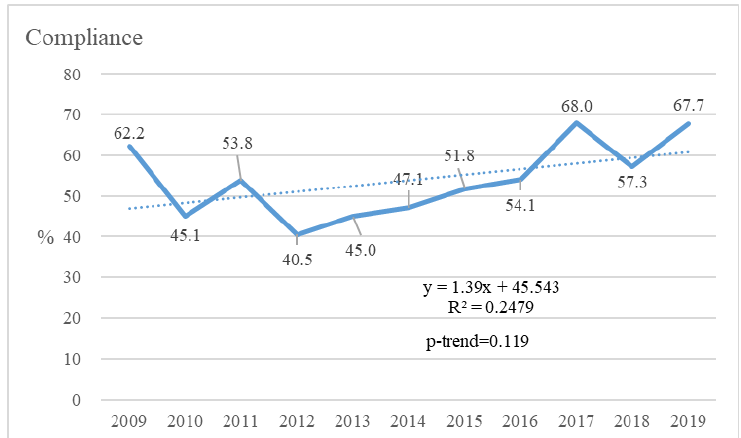
Figure 1. The trend of compliance rate from 2009 to 2019. Since juvenile offender rate had no difference with the test result, the remaining var- iables were further analyzed in the logistic regression model. Among the independent variables, higher exposure rate to secondhand smoke at home (Adjusted odds ratio = 0.977, 95%CI = 0.963 – 0.991), higher smoking rate among senior and vocational high school students (AOR = 0.964, 95%CI = 0.945 – 0.984), and male adolescent rate (AOR = 0.887, 95%CI = 0.818 – 0.962) were associated with lower compliance. Among the test variables, the years of survey (AOR = 1.085, 95%CI = 1.051 – 1.120), inspection during summer vacation (AOR = 1.324, 95%CI = 1.163 – 1.507), chain conven- ience stores (AOR = 3.651, 95%CI = 3.099 – 4.301), supermarkets or hypermarkets (AOR = 1.973, 95%CI = 1.625 – 2.396), and sellers verified with age (AOR = 15.345, 95%CI = 13.159 – 17.893) were associated with better compliance; however, the county/city with the average highest disposable income (AOR = 0.572, 95%CI = 0.468 – 0.698) and second highest dispos- able income (AOR = 0.818, 95%CI = 0.673 – 0.993), and tests on weekends (AOR = 0.784, 95%CI = 0.688 – 0.894) were associated with worse compliance (Table 2). Table 2. Influencing factors of test results ( compliance vs. noncompliance). Variable